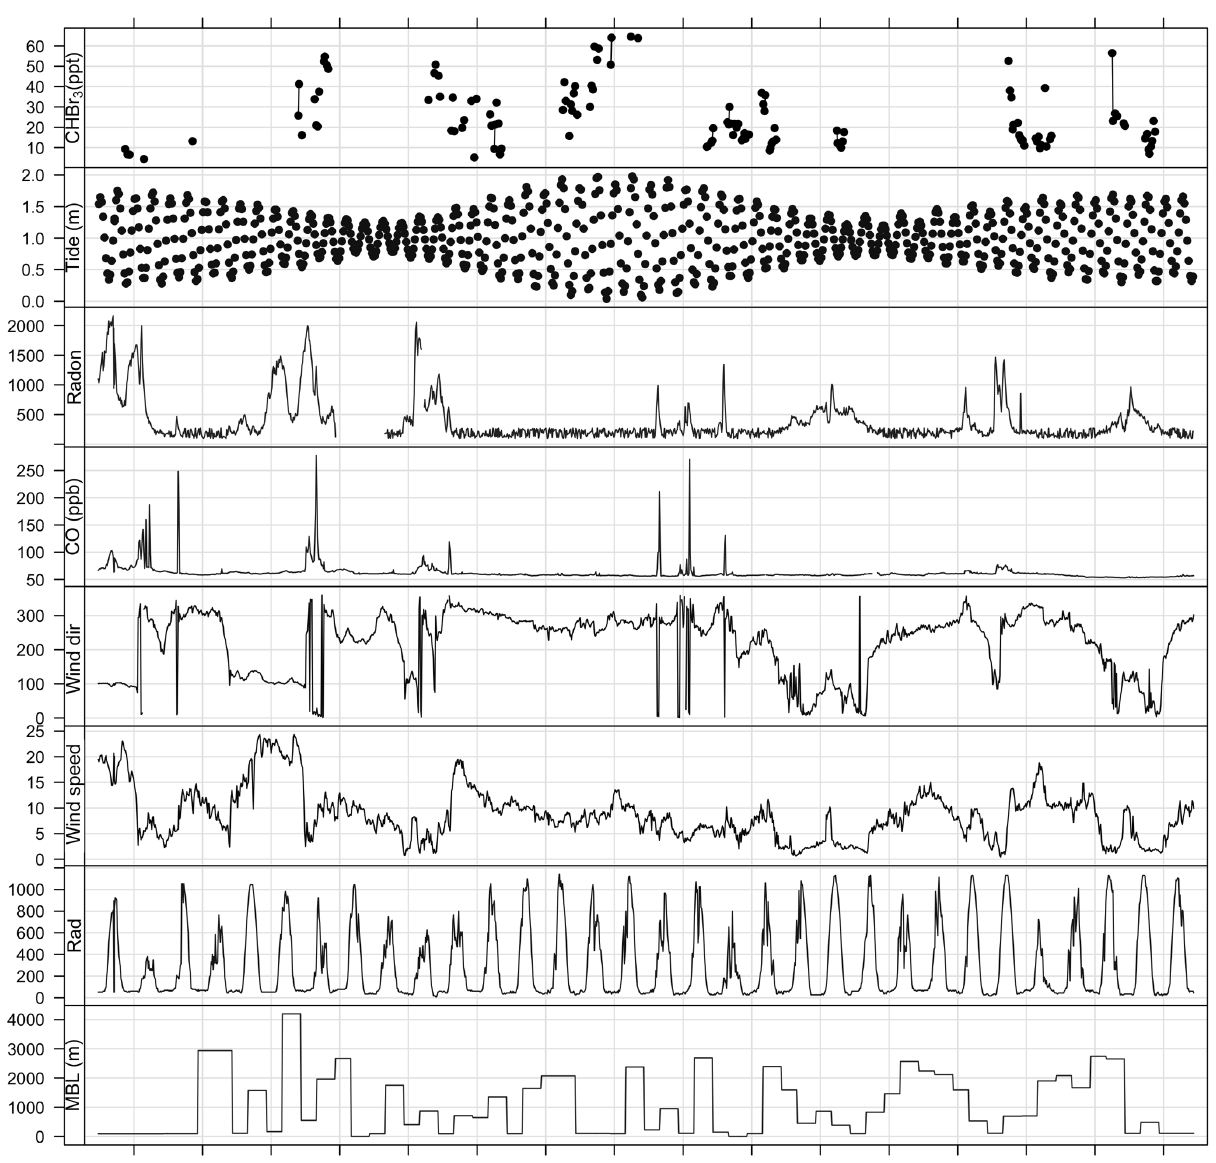
Figure 3. Time series plot of bromoform and meteorological measurements at Cape Point during October/November 2011. Tide height given in metres above SAHO datum, radon in mBqm − 3 , wind direction in degrees, wind speed in ms − 1 , and radiation in Wm − 2